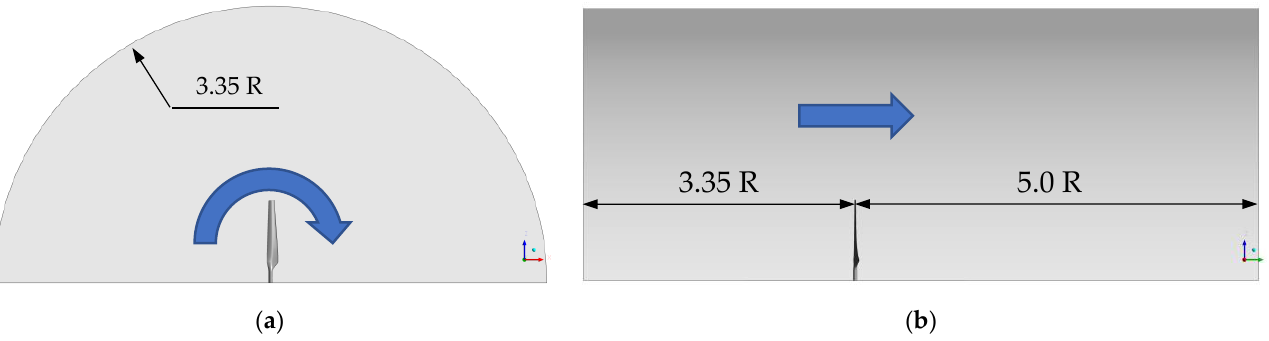
Figure 4. Computational domain shape and size: ( a ) frontal view; ( b ) side view. Note the orientation of the reference coordinate system. Arrows symbolize the relative flow direction.